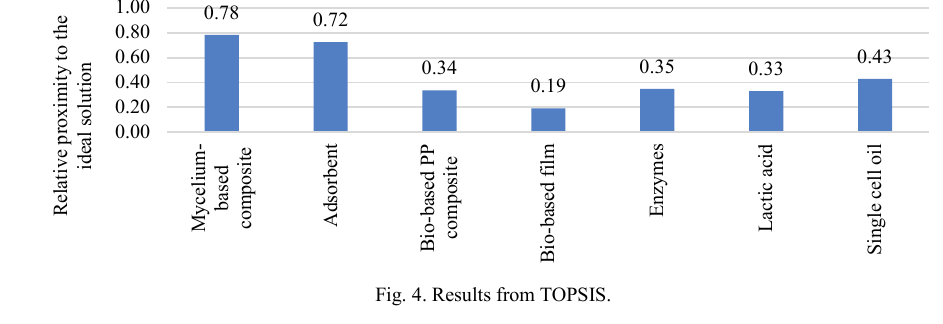
Fig. 4. Results from